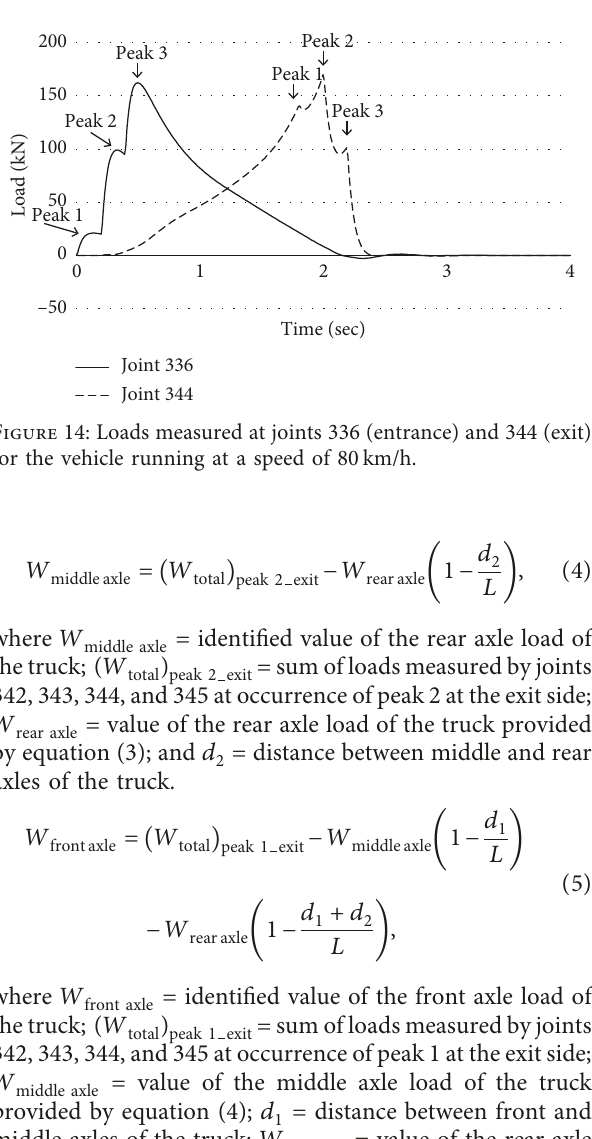
Figure 11: Loads measured at joints 336 (entrance) and 344 (exit) for the vehicle running at a speed of 20km/h.